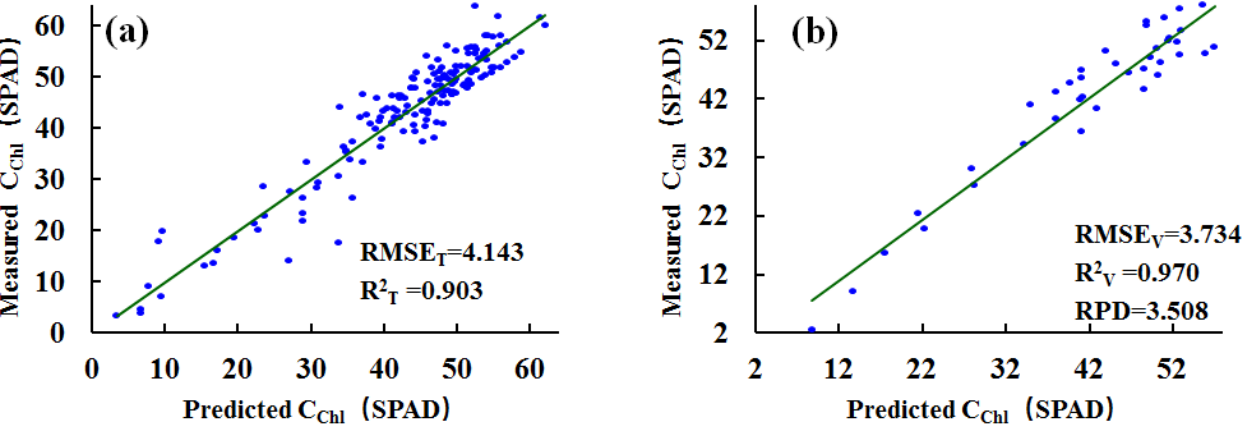
Figure 14. The estimated results of SPAD value for ( a ) training set and ( b ) validation set based on pretreatment WPD-(1/R)’-PCADR at milk stage.